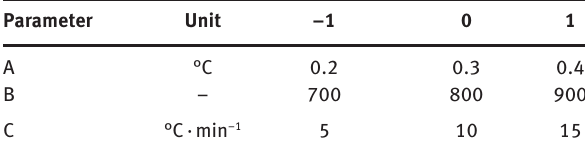
Table 4: Parameters and levels for the response surface design.